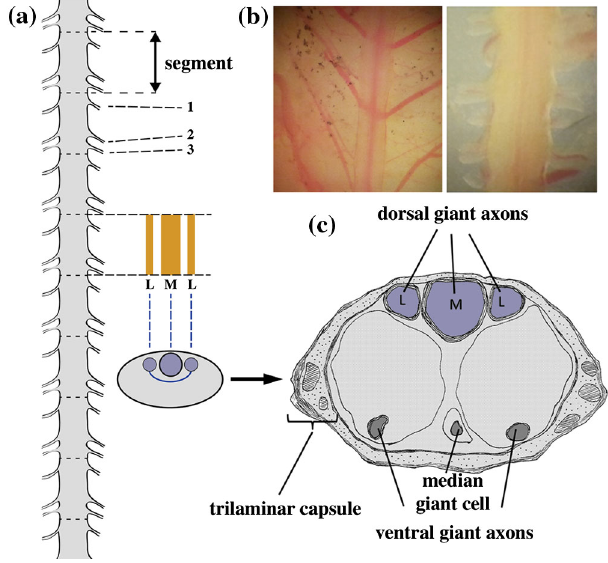
FIG. 2. (a) Schematic representation of an earthworm ventral cord with the segments and three pairs of roots, (b) ventral cord with and without muscular tissue, and (c) internal structure of the ventral cord redrawn from Ref. [26]. Median and lateral giant fibers are marked with M